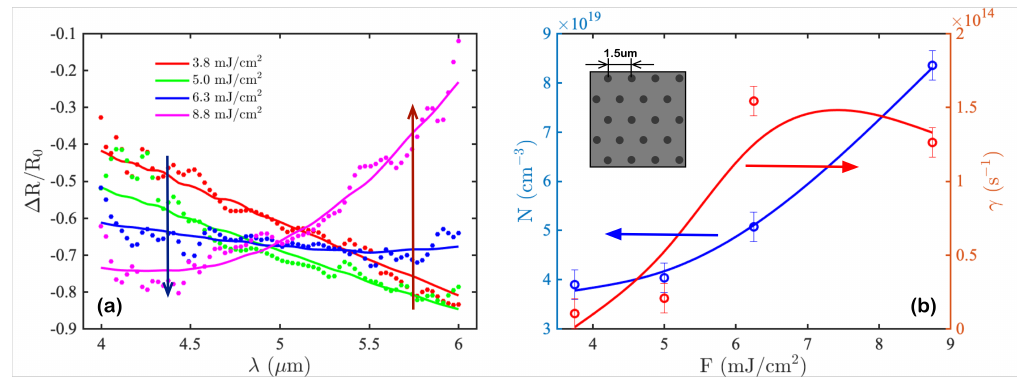
Figure 1. ( a ) Change of the reflectance, ∆ R / R 0 , at the temporal overlap between the pump and signal as a function of signal wavelength λ recorded for the pump fluences of 3.8 mJ/cm 2 (red), 5.0 mJ/cm 2 (green), 6.3 mJ/cm 2 (blue) and 8.8 mJ/cm 2 (magenta). The dots denote the experimental results, and the solid lines show the model fitting. The arrows indicate the change of reflectance with increasing pump fluence at a given wavelength, on the shorter and longer spectral ends, blue and red, respectively. ( b ) The carrier concentration, N , (blue) at the sample surface and its scattering rate, γ , (red) as a function of the pump fluence. The curves were reconstructed from the experimental data shown in ( a ). The insert shows the top view of the structured silicon used in this